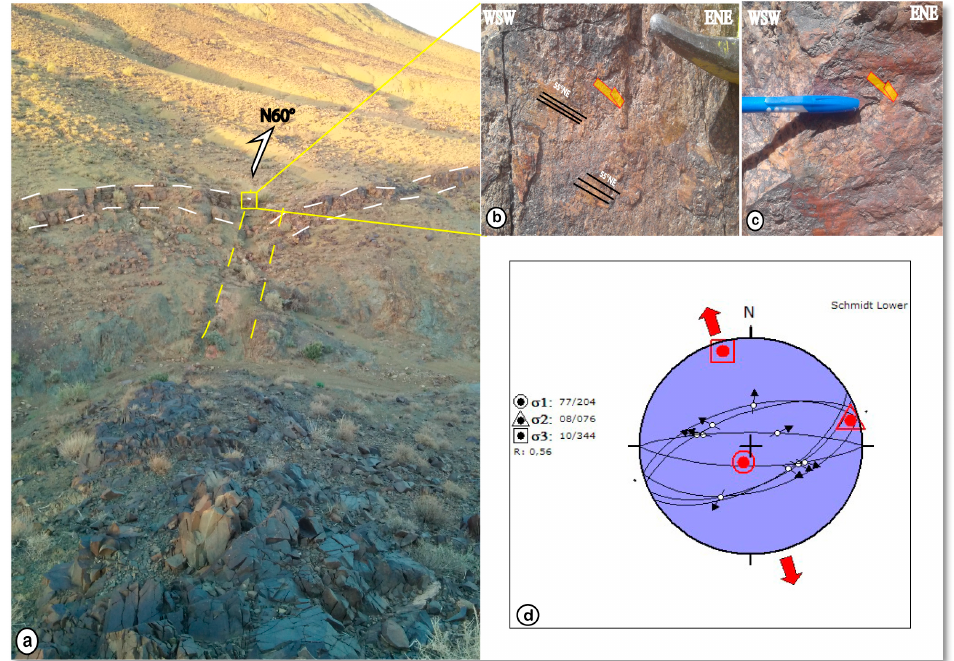
Figure 8. ( a – c ) Field photographs show a normal fault crosscutting the Micmacca breccia at the base of the middle Cambrian. ( d ) Stereographic projection of the fault analysis and the interpreted stress axis during the Cambrian synsedimentary tectonic event.